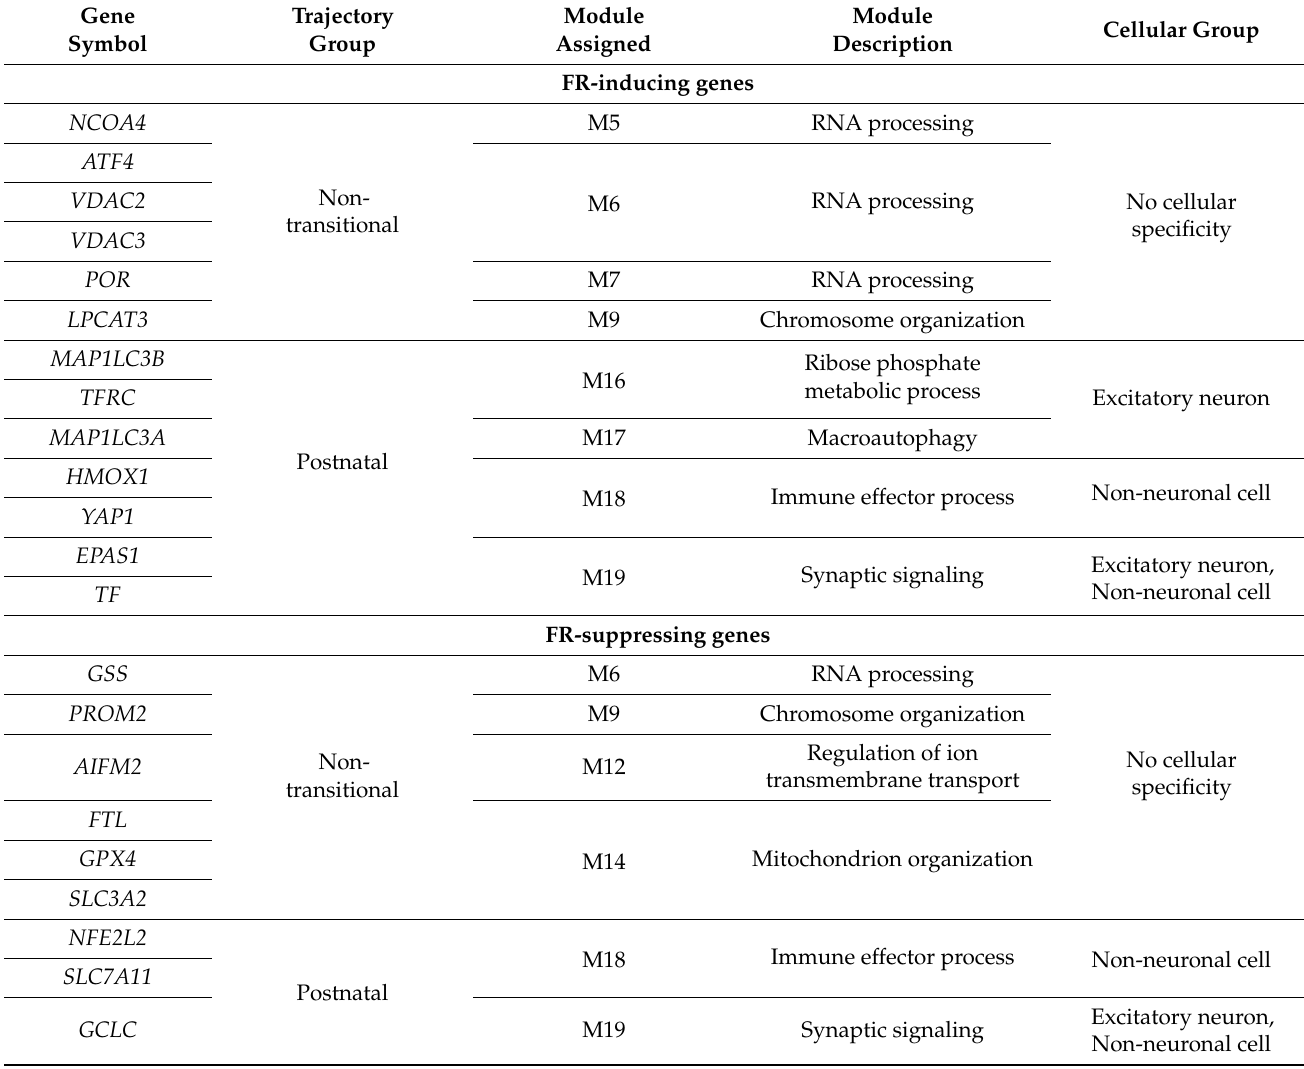
Table 1. List of ferroptosis genes in human dorsolateral prefrontal cortex